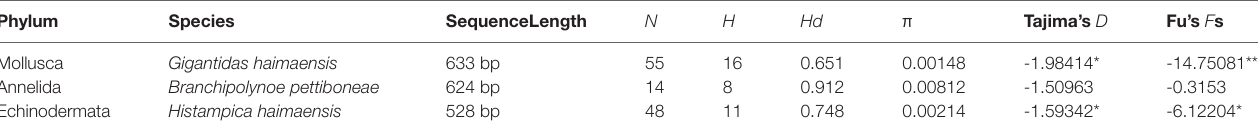
TABLE 2 | DNA polymorphism and neutrality tests values for the three representative macrobenthos species in Haima cold seep based on COI sequences. Phylum